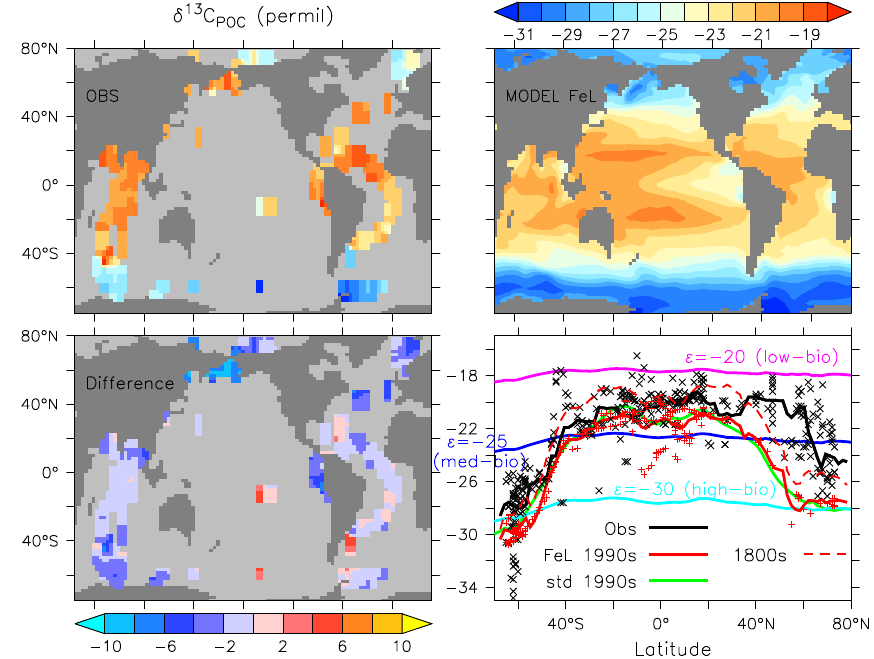
Fig. 8. δ 13 C of particulate organic carbon (POC) from observations (Goericke and Fry, 1994) averaged on a 5 ◦ grid (top left) and model FeL (top right; 1990s averaged over the top 100m) presented as longitude-latitude maps. Bottom left: difference model FeL minus observations. Bottom right: zonal averages as a function of latitude. Symbols show individual observations (black) and FeL model results (red) at the locations of the observations. Lines show zonal averages using grid points where observations are available only. Red dashed line represents results from the preindustrial FeL model simulation. Model std is shown in green; other models are low-bio (purple), med-bio (blue) and high-bio (light